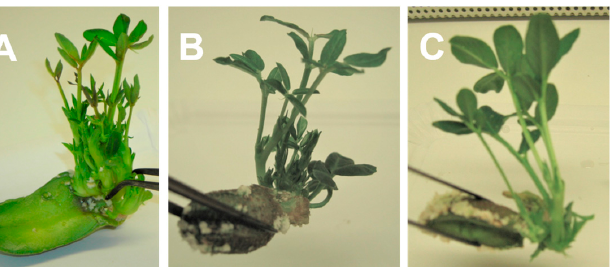
Figure 4. Application of selected TIS immersion regimes three to varieties, cultured in liquid MS